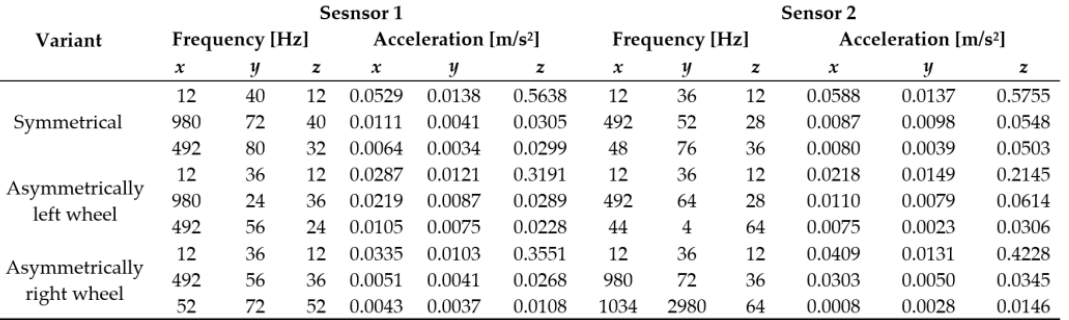
Figure 16. The resulting dominant frequencies and the corresponding acceleration when crossing the obstacles.